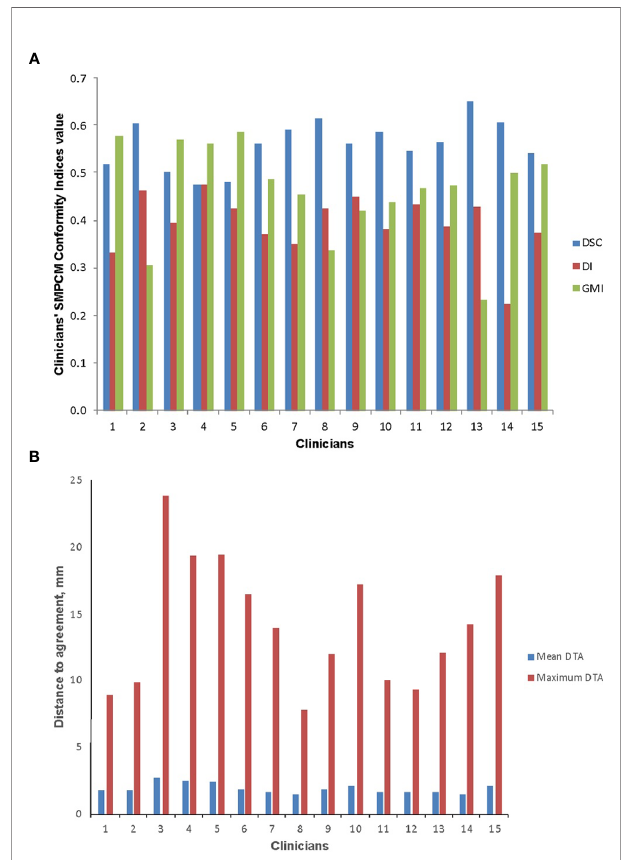
FIGURE 2 | Conformity indices (A) and distance to agreement (DTA) (B) results for clinicians ’ superior and middle pharyngeal constrictor muscle (SMPCM) contours DI, discordance index; DSC, DICE similarity co-ef fi cient; GMI, geographical miss index.